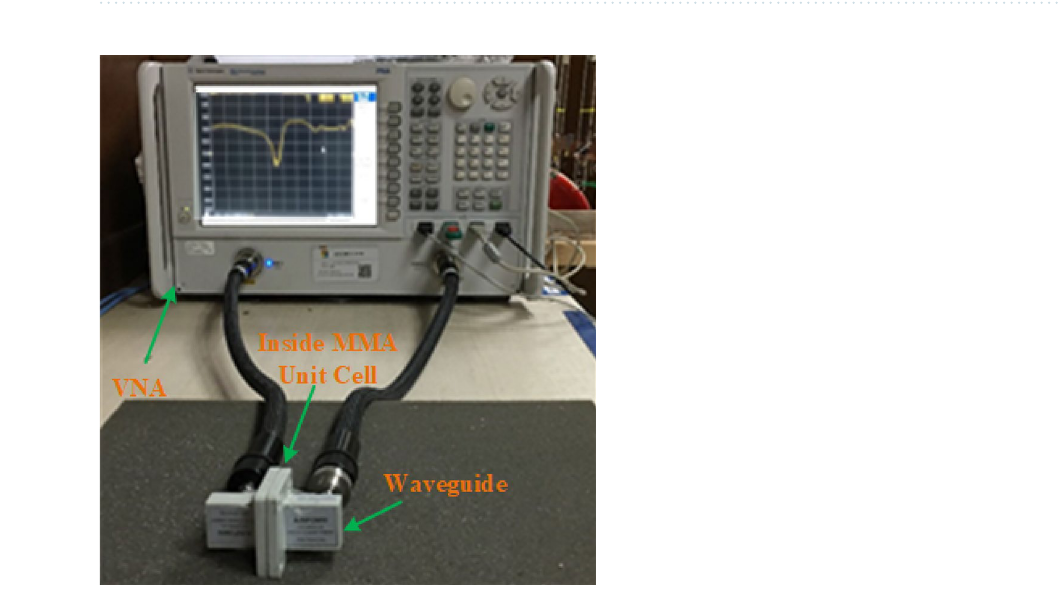
Figure 21. Fabricated prototype of MAA ( a ) unit cell ( b ) array.